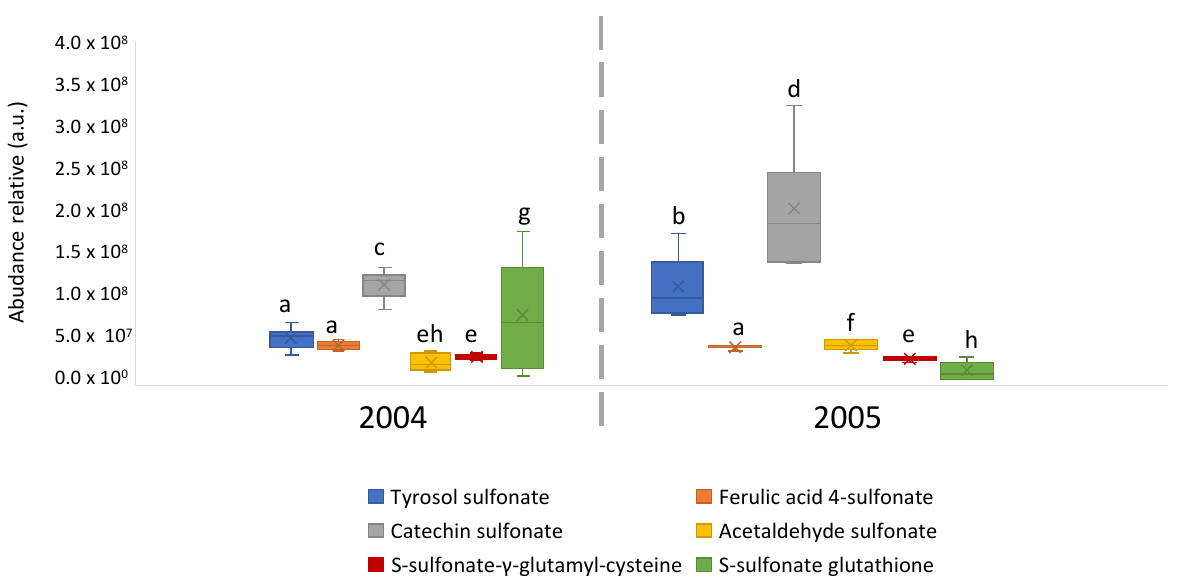
Figure 5. Box plots of the relative abundances of putatively identified sulfonated analogues of tyro- sol, ferulic acid, catechin, acetaldehyde, γ -glutamyl-cysteine, and glutathione related to the good oxidative state (G) of aged wines from 2004 and 2005 vintages. Means not sharing a letter are signif- icant ( p < 0.05).